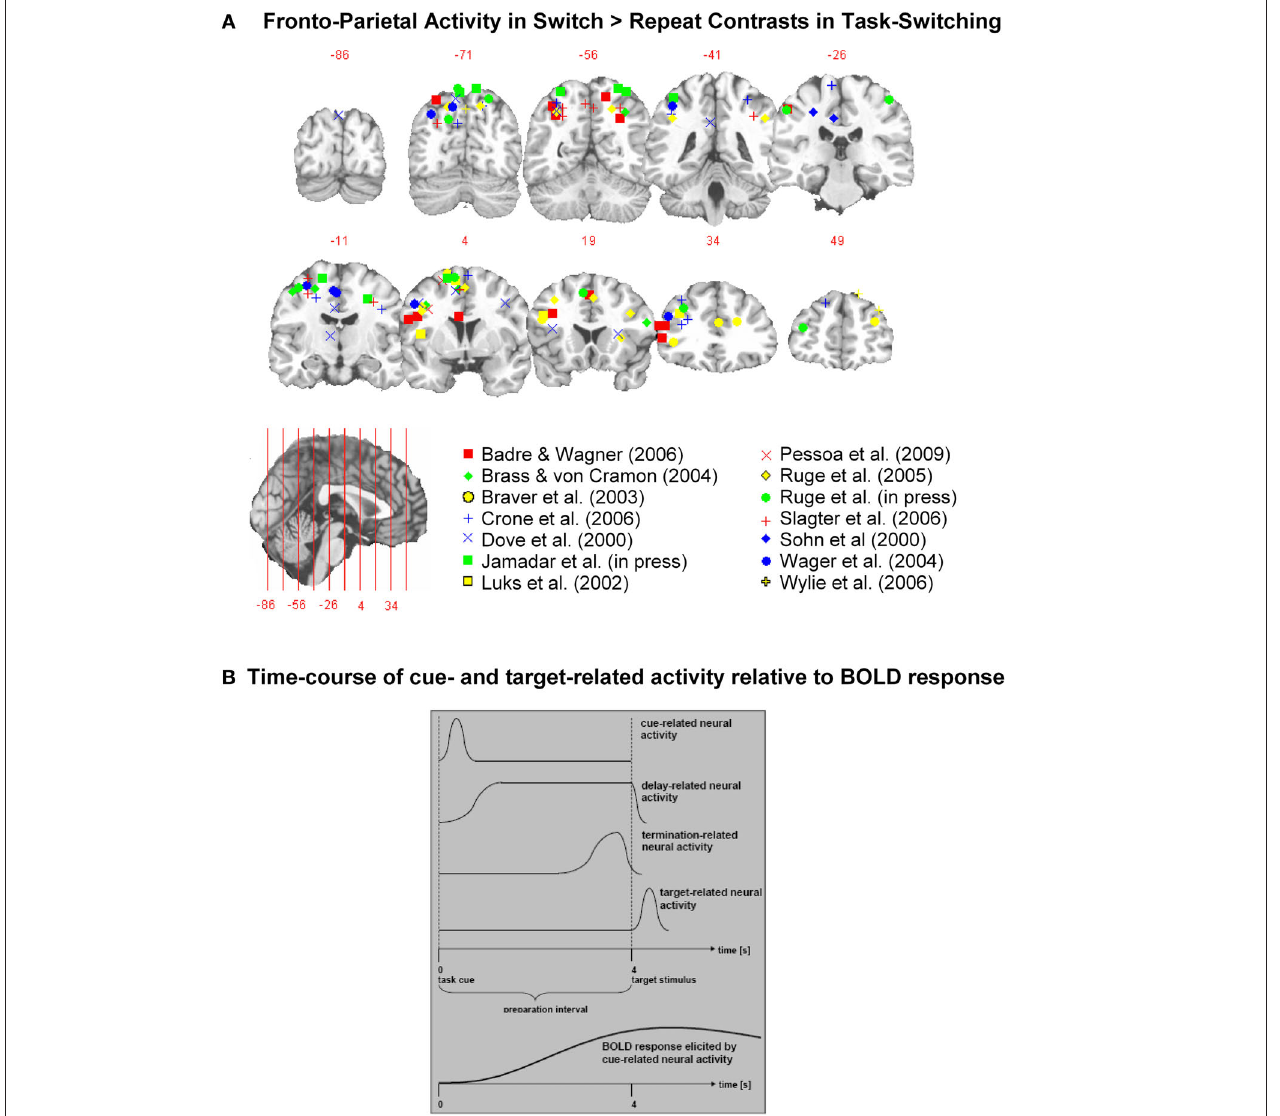
Figure 2 | Functional Magnetic resonance imaging (fMri) studies measure a blood oxygenation-level dependent (BOLD) signal that is related to complex changes in blood flow, blood volume, and oxygenated and deoxygenated haemoglobin (see Logothetis, 2002 for a review). fMRI has superior spatial resolution; thus, it provides important information on the neuroanatomy of cognitive processing. (A) Fronto-parietal activity in switch > repeat contrasts in cued task-switching studies, independent of CTI manipulation. Studies were included a) if they included at least one CTI condition that is considered long enough for advance preparation (i.e., CTI>500ms) but not long enough to require maintenance of a prepared state, and b) if they reported Talairach or MNI coordinates for significant Swt-Rpt activity. Hotspots indicate the peak of activity in each cluster reported in each study. Peaks that fall between the presented slices are shown on the closest corresponding slice. It may be seen that while there is variation in the precise localization of switch > repeat activity, there is also a considerable degree of consistency, with DLPFC, VLPFC, PM, pre-SMA and sPPC showing consistent activation. (B) fMRI studies addressing the concept of advance preparation face the challenge of how to disentangle two or more temporally overlapping BOLD responses, i.e., one or more responses that are associated with preparatory activity and one or more responses associated with target-related activity. Although no technique offers a complete solution to this challenge, a number of different approaches have been used